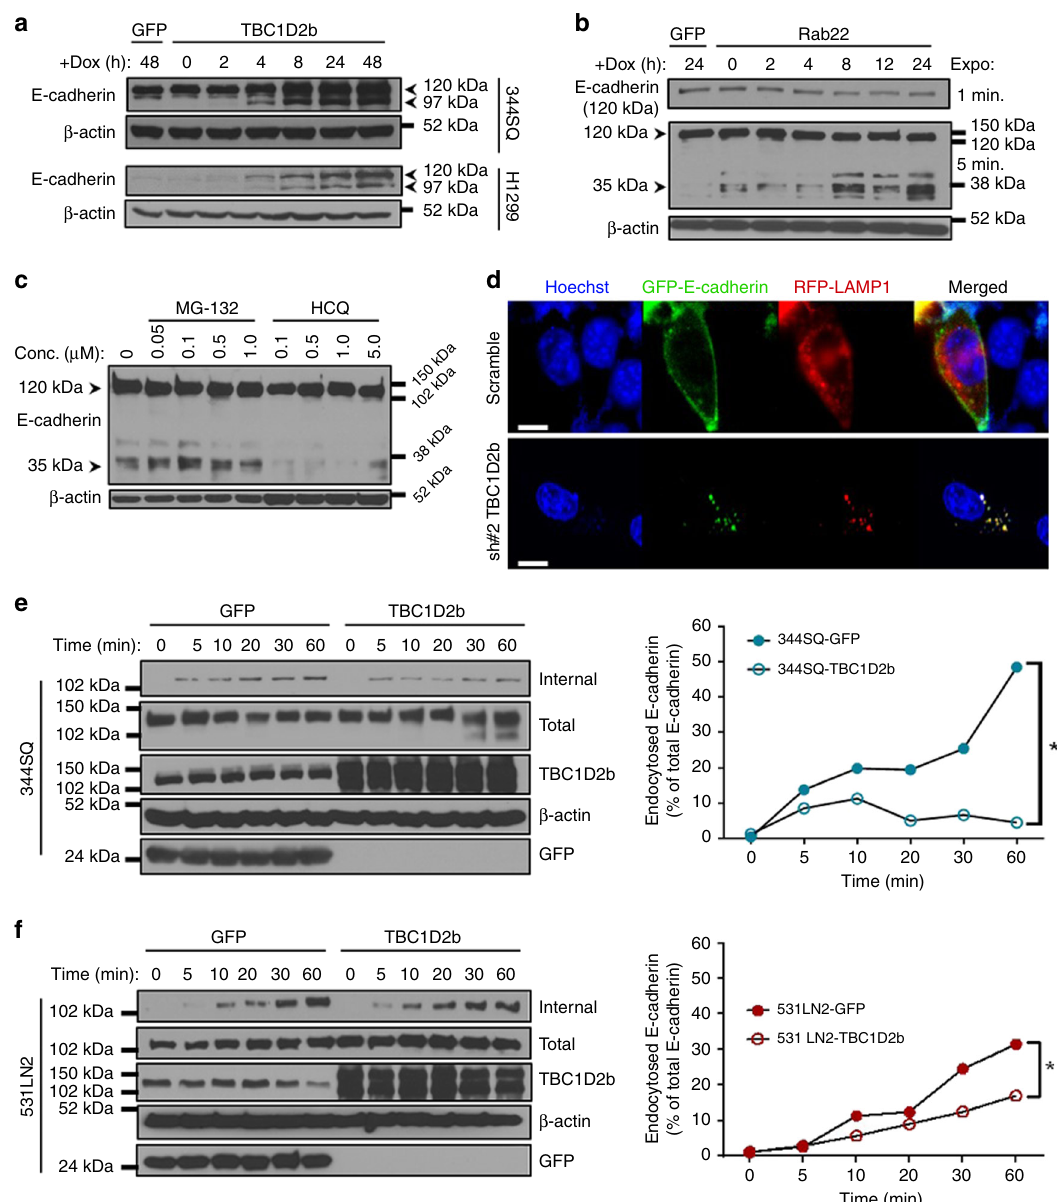
Fig. 6 TBC1D2b/Rab22 axis regulates endocytosis of E-cadherin. a Immunoblot of E-cadherin in 344SQ and H1299 cells expressing TBC1D2b. Accumulation of a faster migrating band (~97 kDa) appears within ~4 h of TBC1D2b overexpression. Arrows designate different molecular weights of E-cadherin species. b Immunoblot of E-cadherin in 393P overexpressing human GFP-Rab22 over 24 h. E-cadherin (120 kDa) expression decreases upon Rab22 overexpression while a major degradation product (35 kDa) is observed and is dependent on Rab22 expression. c Treatment of 393P-GFP-Rab22 cell line with the lysosome inhibitor hydroxychloroquine (HCQ) or the proteasome inhibitor MG-132 at increasing concentrations for 24 h. d Upon TBC1D2b knockdown GFP-tagged E-cadherin co-localizes with RFP-LAMP1 lysosomes by live cell imaging in the 344SQ cell lines. Scale bars represent 10 µ m. e E-cadherin internalization was assessed in the 344SQ-TBC1D2b and ( f ) 531LN2-TBC1D2b overexpressing cell lines through the biotin method. Quanti fi cation of western blot demonstrates that TBC1D2b suppresses E-cadherin internalization; all asterisks indicate statistical signi fi cance by t -test (* p ≤